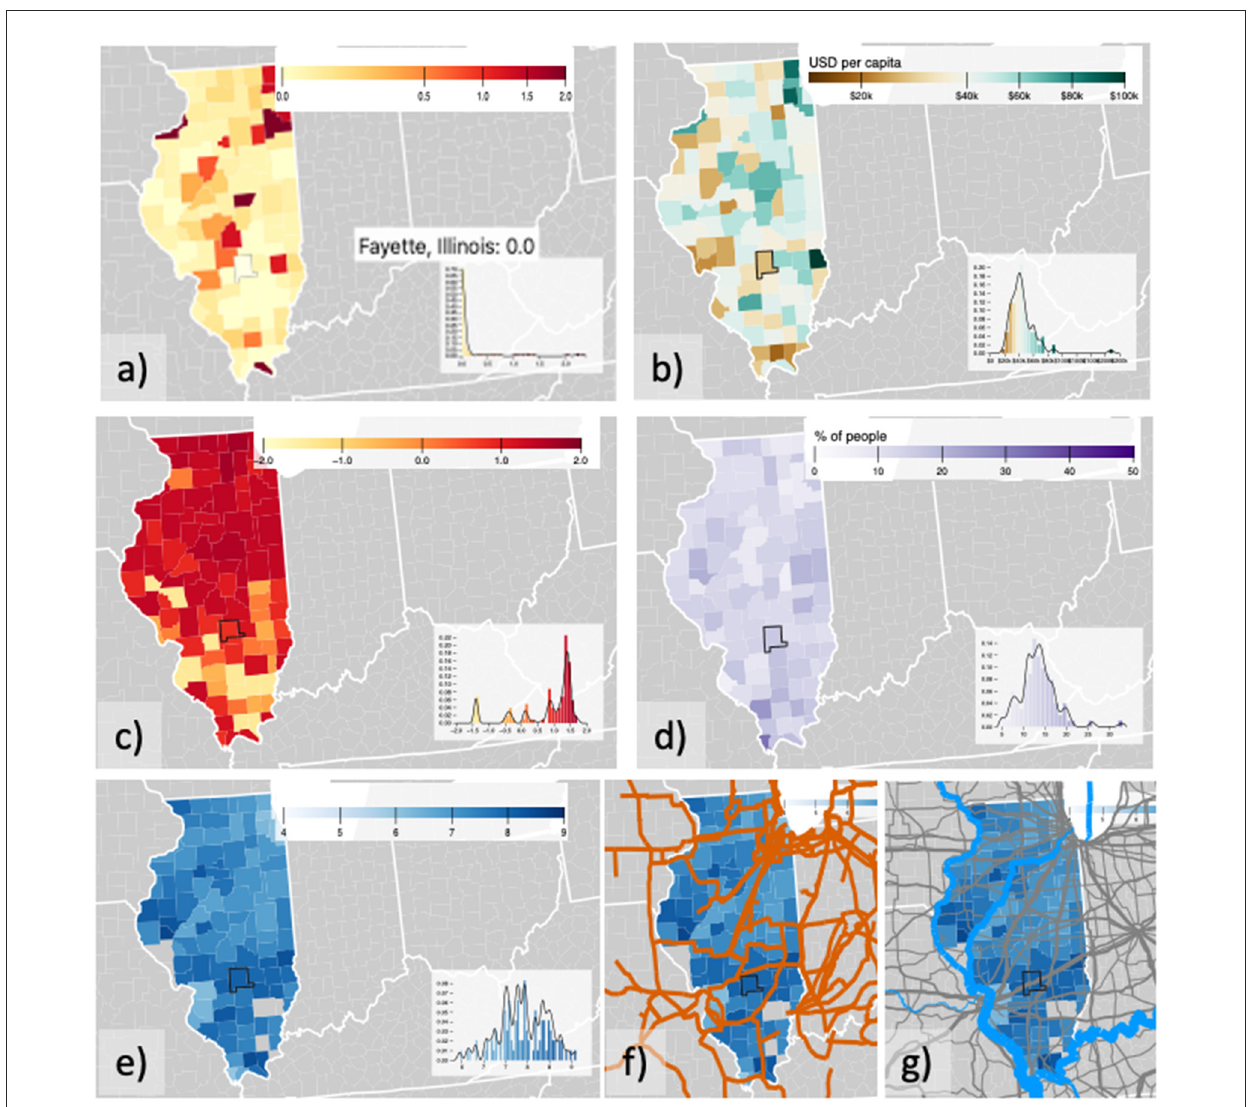
FIGURE10 Maps display: (a) the average water stress (unitless) from 2010 to 2015 for the state of Illinois and the result for the county of Fayette, IL is highlighted to note that it has an average water stress of 0; (b) the per capita personal income across Illinois (based on the 2019 Census data collected). Fayette, IL is on the lower end of personal income with a value of $40 k/person; and (c) the level of water quality across Illinois. Fayette, IL has some concerns regarding water quality with a ranking of 0.8 out of two where two is the worst ranking; (d) the percentage of population below the poverty level across Illinois. Fayette, IL has a moderately high percentage (16%) of people below poverty level relative to other counties; (e) the 100-year flood risk for Illinois, and depicting the high flood risk value of eight out of nine for Fayette, IL, and (f) ; flood map that includes overlays of major highway (thin gray lines), railways (thick gray line); as well as waterways (blue lines); and (g) flood map that includes overlay of electrical transmission lines at 345 kV, and indicating that these transmission lines run through Fayette,